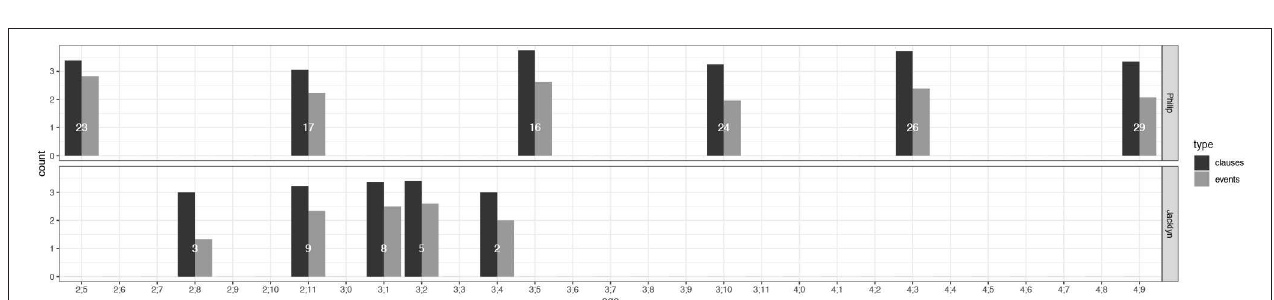
FIGURE 12 | Mean number of events referred to in the adults’ two-clause chains.